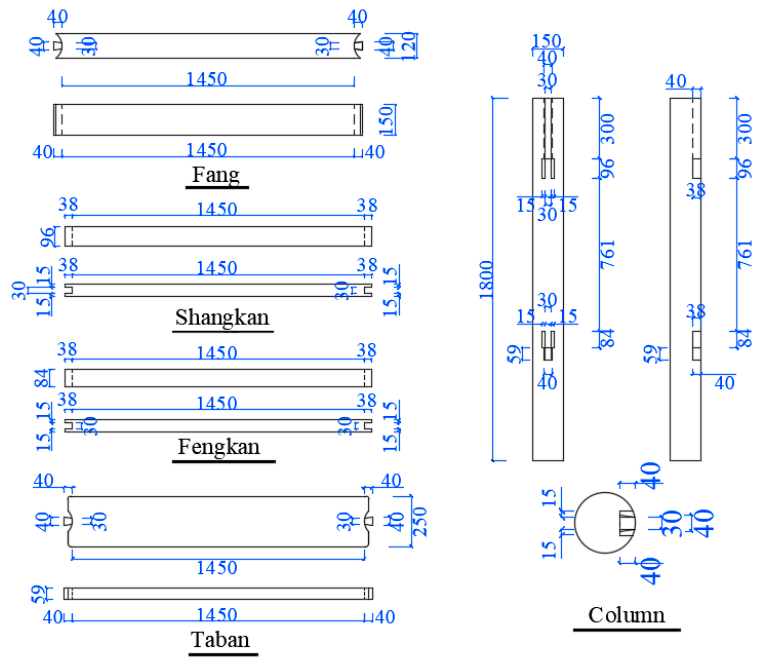
Figure 3. Dimensions of the specimen (mm).